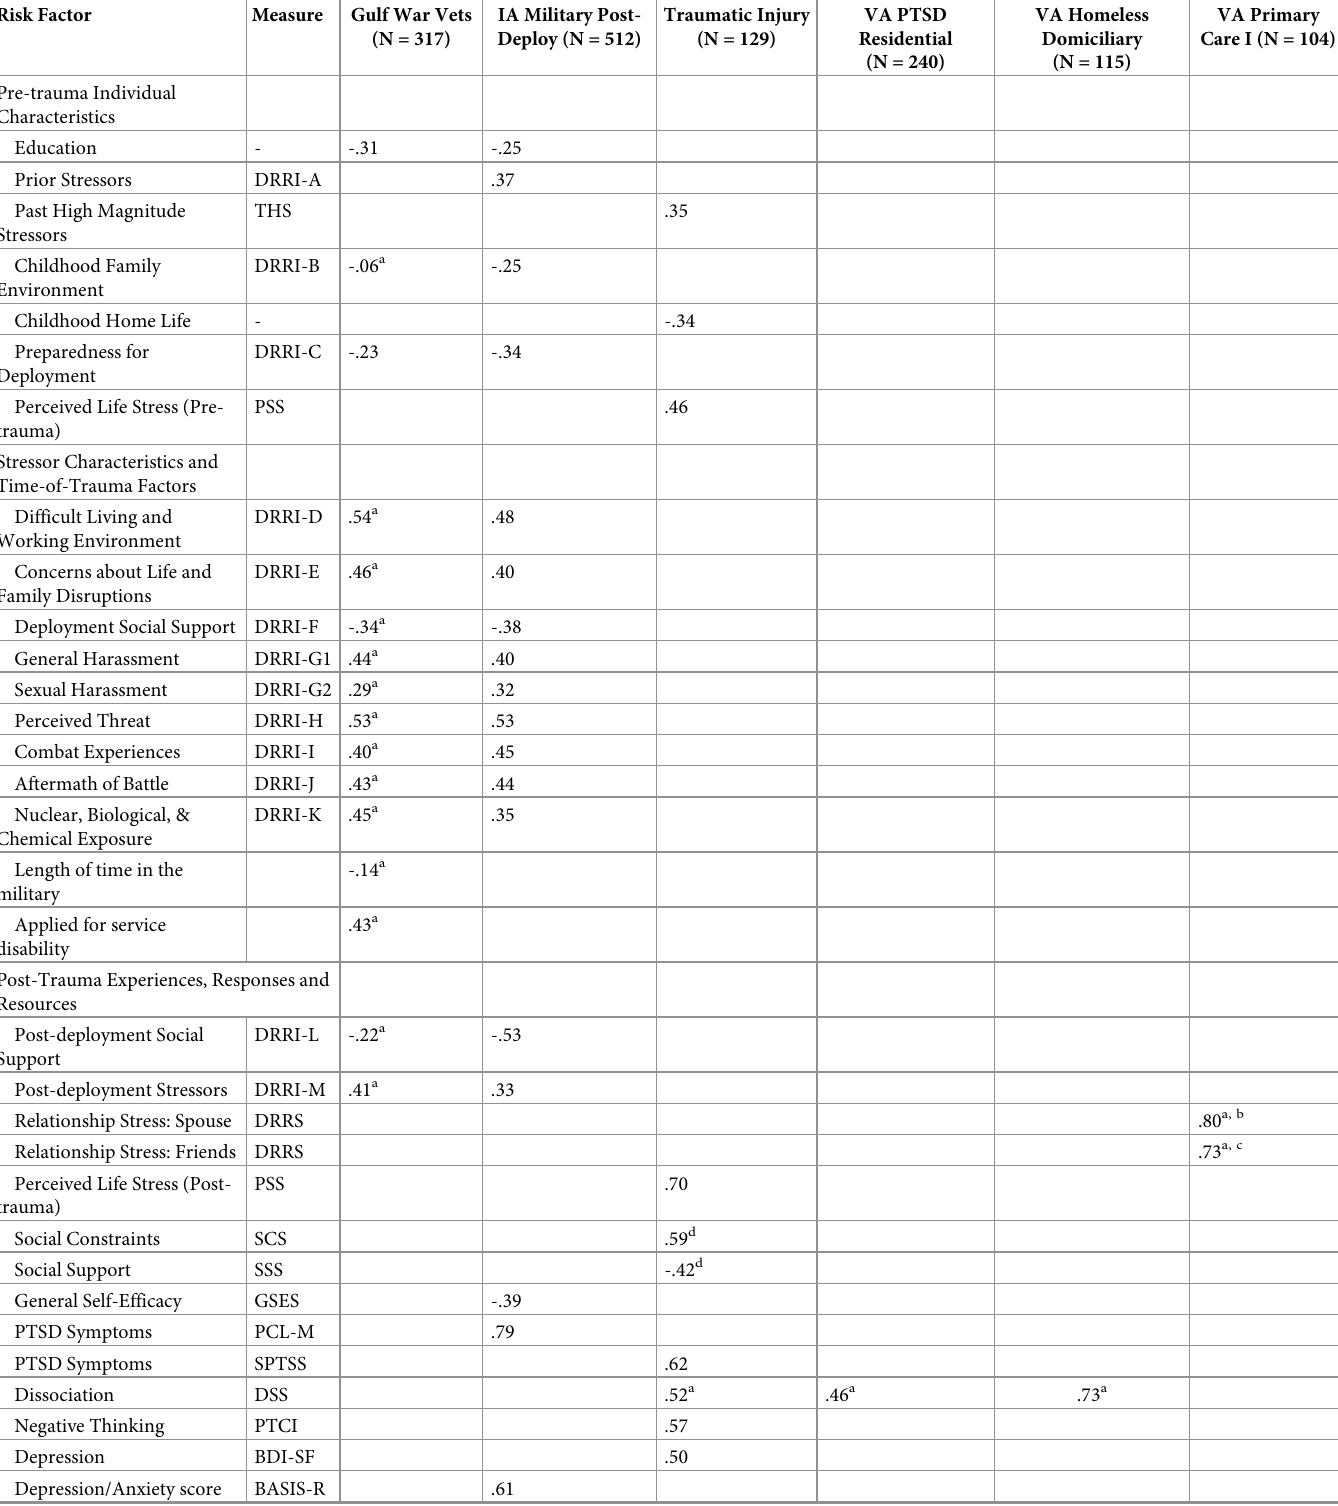
Table 2. Risk factors assessed, measures used, and correlations between risk factors and PTSD symptoms in six